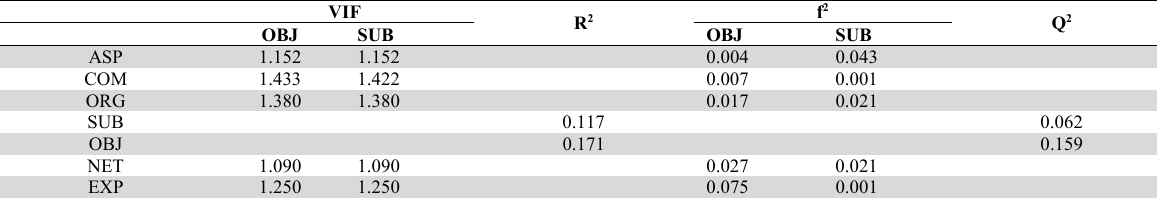
The results of VIF, R 2 , f 2 and Q 2